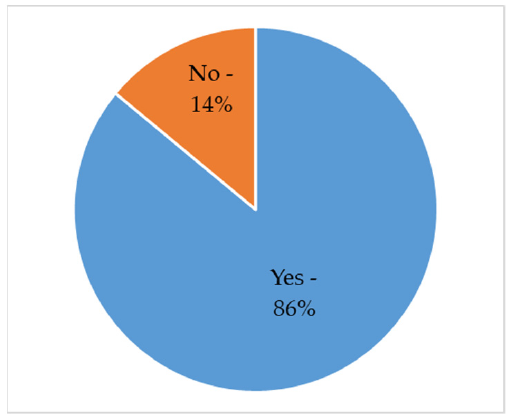
Figure 8. Selected survey results—an analytical–political perspective: are there changes currently planned in the strategic documents of the province's development that would lead to the implemen- tation of the European Green Deal?